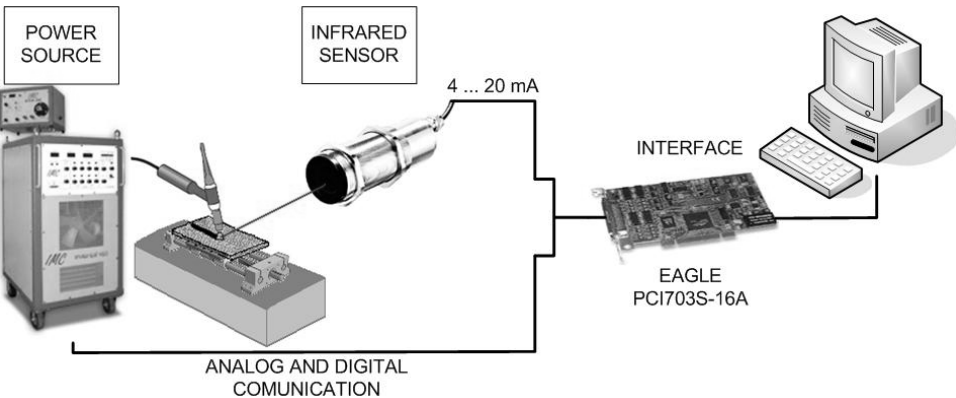
Figure 4. Experimental scheme. Block diagram of the data-acquisition and control